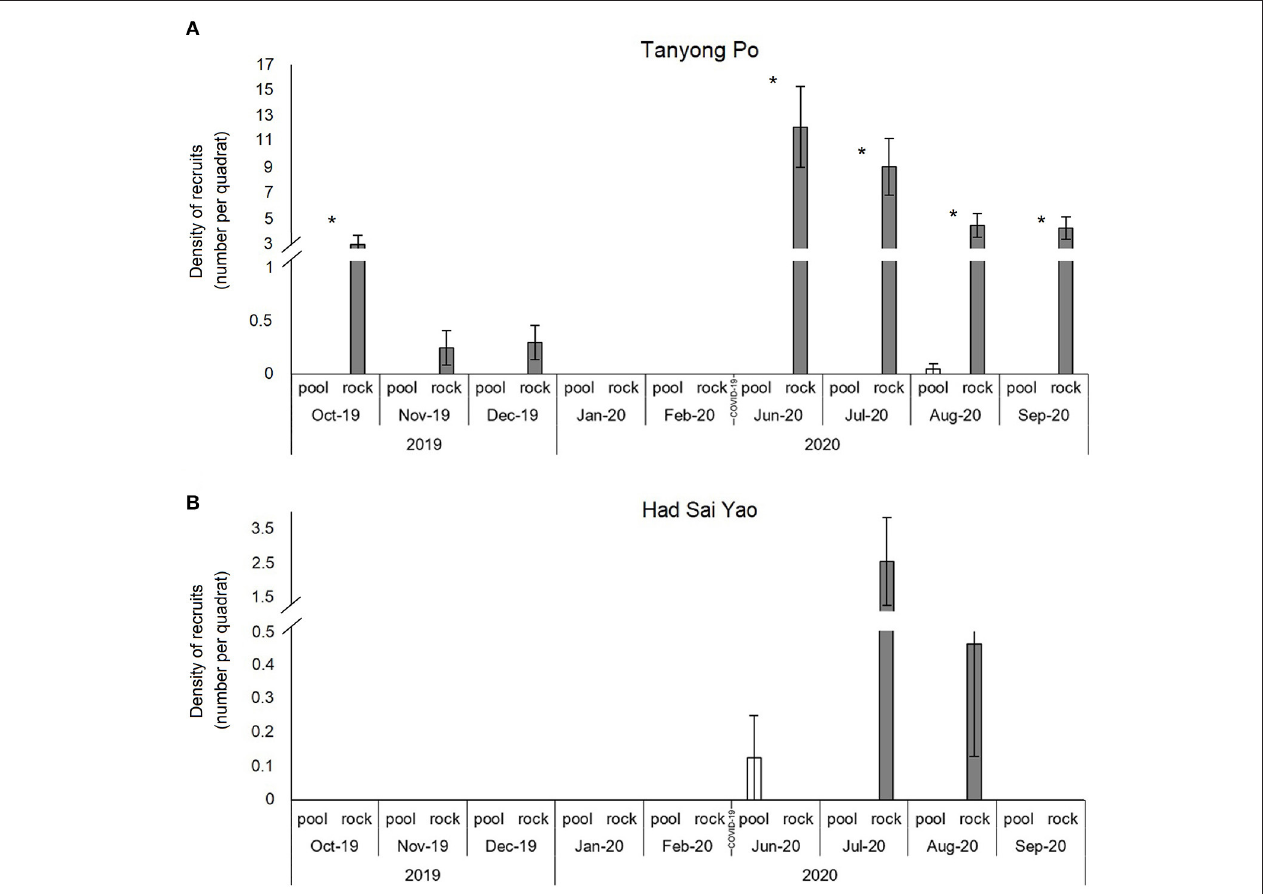
FIGURE 5 | Density of recruits (mean ± SE) in rock pools and on emergent rock from October 2019 to September 2020. Samplings were not carried out from March 2020 to May 2020 due to logistical difficulties during COVID-19 lockdown. (A) and (B) Tanyong Po and Had Sai Yao, respectively. Icon: *significant differences between habitats as suggested by pairwise tests.